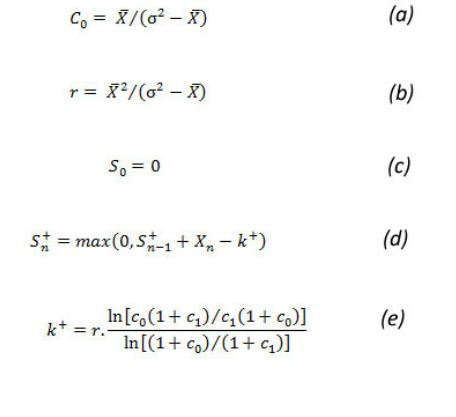
Figure 7. Negative binomial cumulative sum (CUSUM) equations. k = reference value, (r,c) = parameters of negative binomial distribution, S n = CUSUM score, sigma =standard deviation, X n = number of cases in current time interval, X-bar = mean number of cases, + superscript refers to values always being